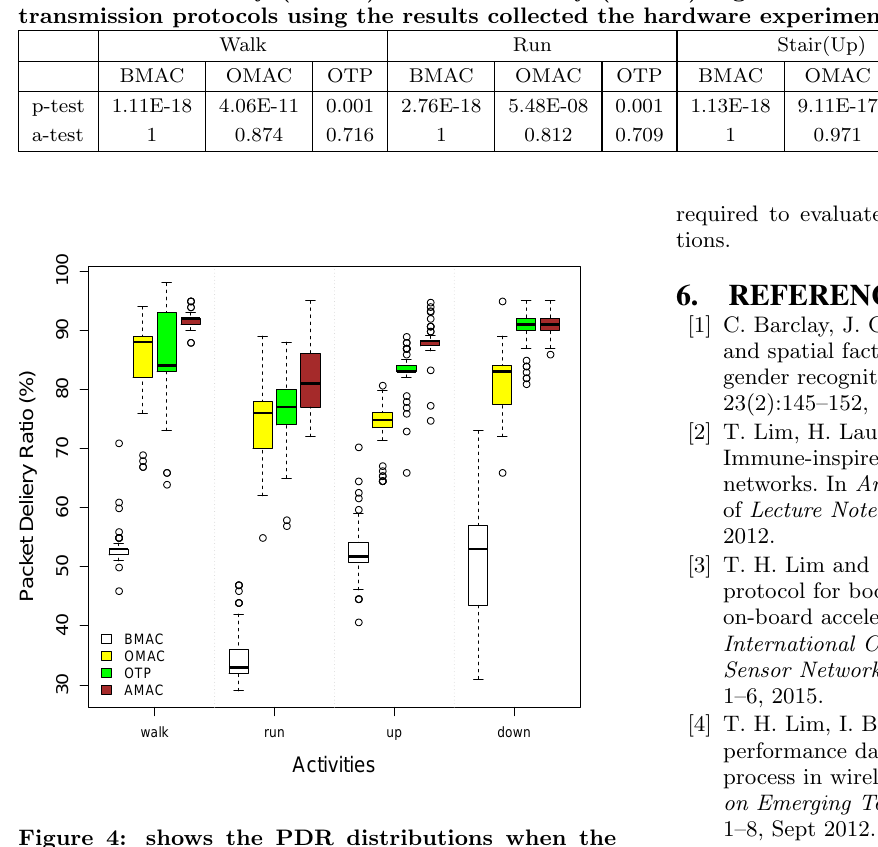
Figure 4: shows the PDR distributions when the participants are asked do different activities